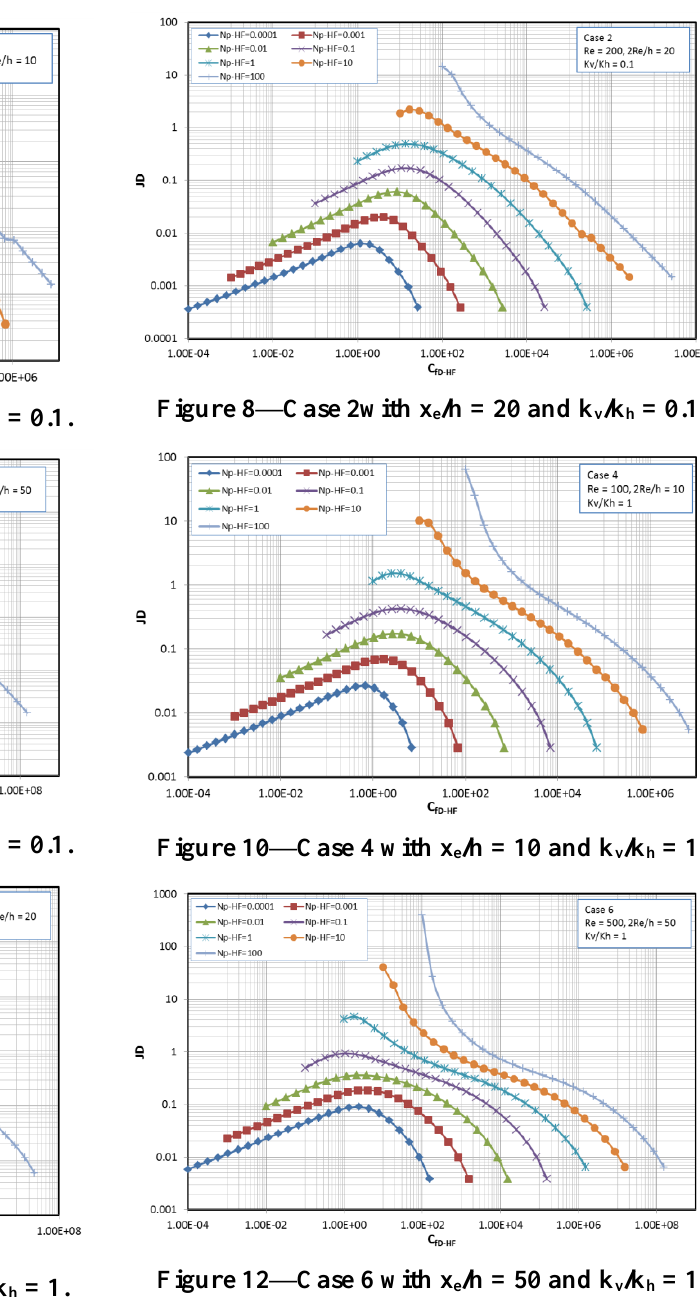
Figure 11—Case 5 with x